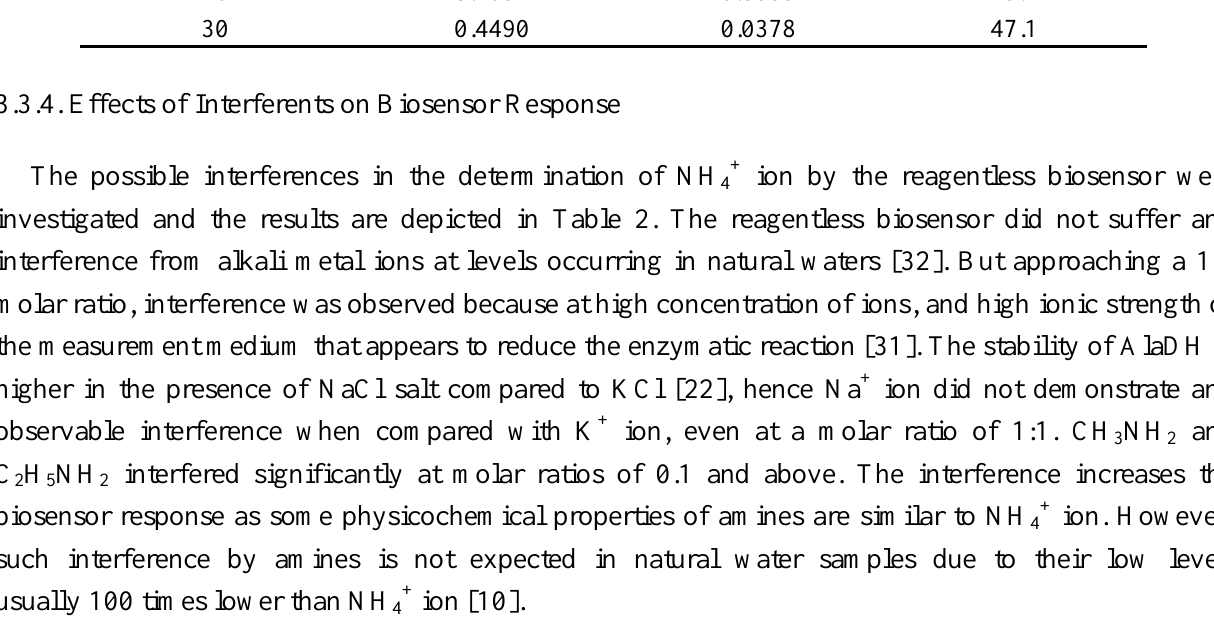
Table 2. The effect of Na + , K + , CH